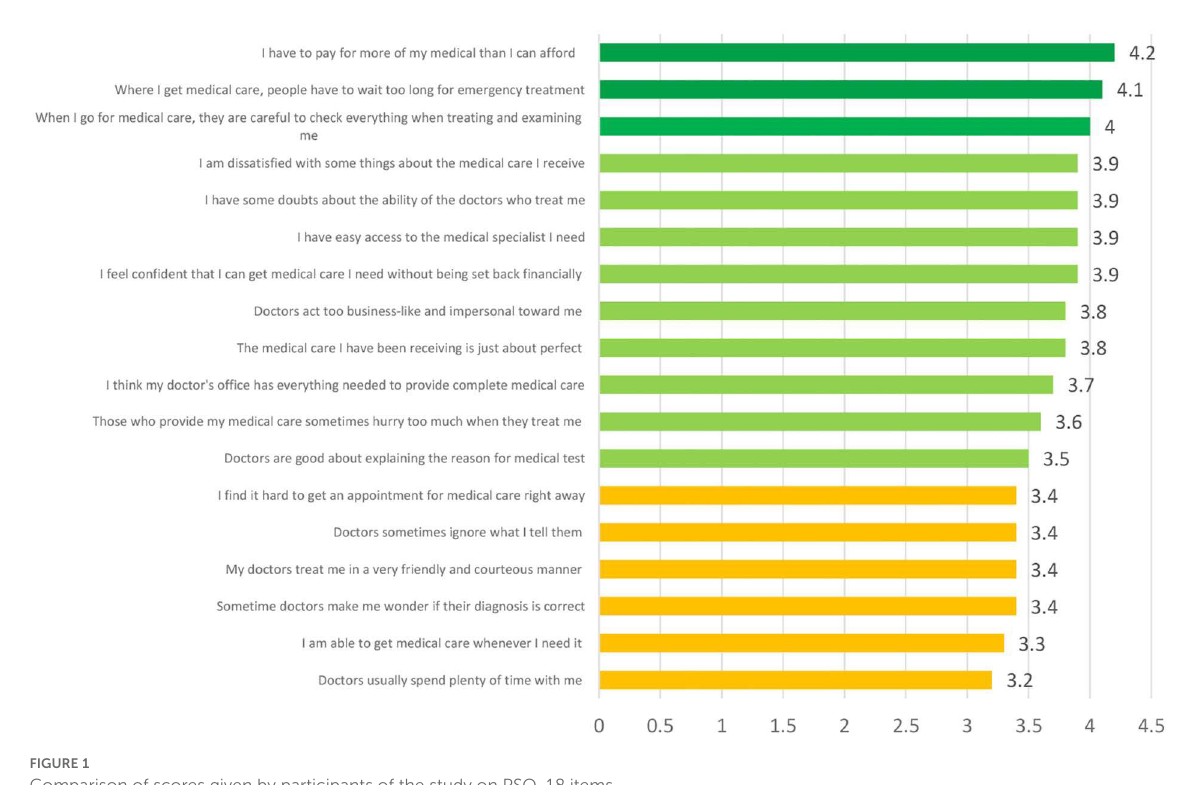
were recruited from King Saud Medical City (55%) and King Abdulaziz University hospital